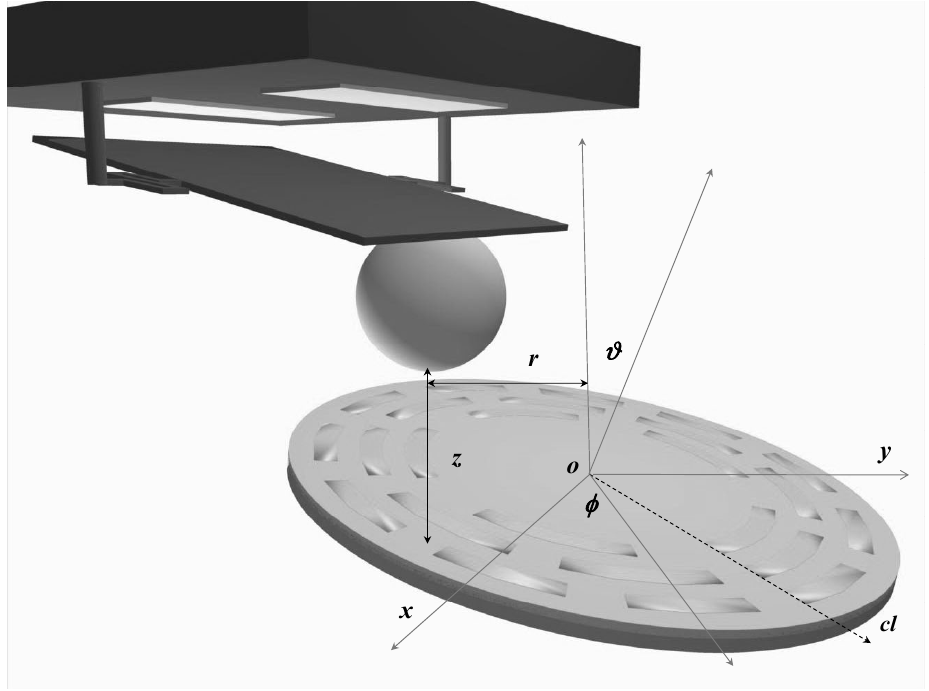
Figure 1. Schematic of the experimental setup. Three regions with n tr = 5,8,11 deep trenches are shown. The actual sample has n tr = 50,75, ,300 trenches situated at different radii. The region · · · with n tr = 50 has inner and outer radii of 50 r i = 4.00 mm and 50 r o = 4.15 mm. A gap of 200 µ m n r = 150 µ m. The x , y follows. All gaps have the same radial extent and all trenches have n r o i − { } plane defines the plane of rotation of the spindle, selected to be parallel to the MTO’s substrate. cl is the line where all regions with different n tr have a common trench interface. ϑ is the change in the instantaneous axis of rotation, φ = ω t is the angle of rotation. The distance z is determined from the vertex of the metal-covered sphere to the top of the rotating sample. r is the distance from the sphere’s vertex to the center o of the rotating sample. Displacements ∆ r between o and the axis of rotation and the Au film covering the rotating sample are not